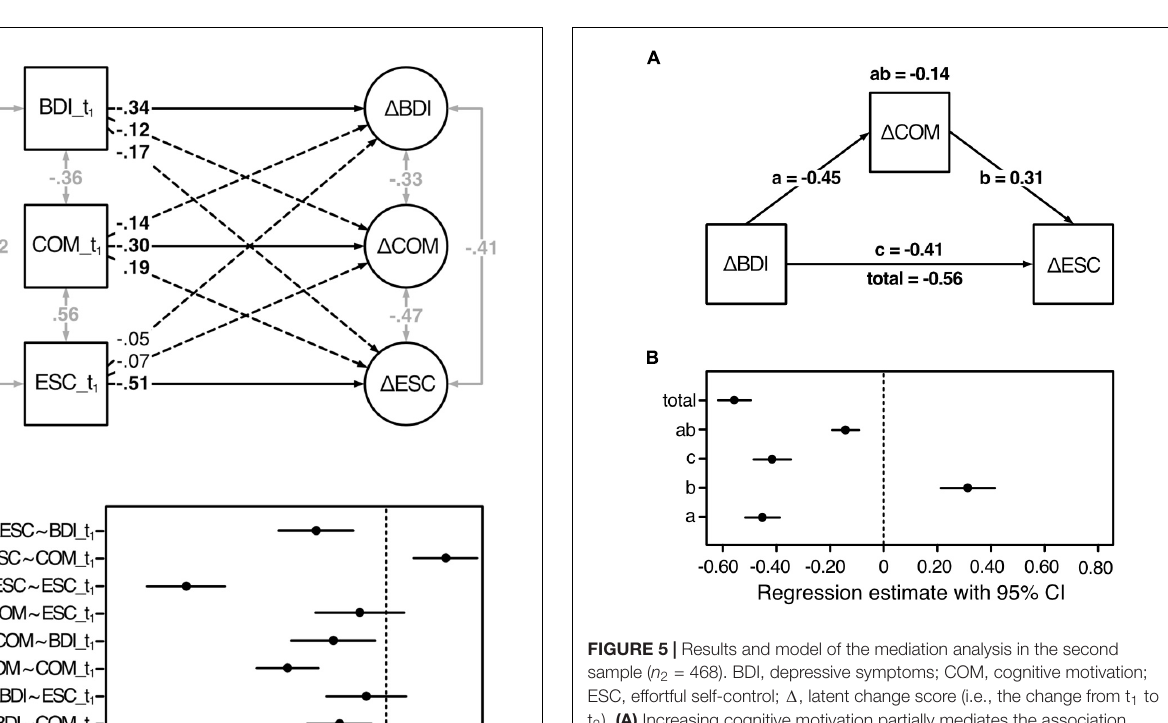
predict (cid:49) BDI [ b = − 0.09, 95% CI ( − 0.15; − 0.03), β = − 0.14]